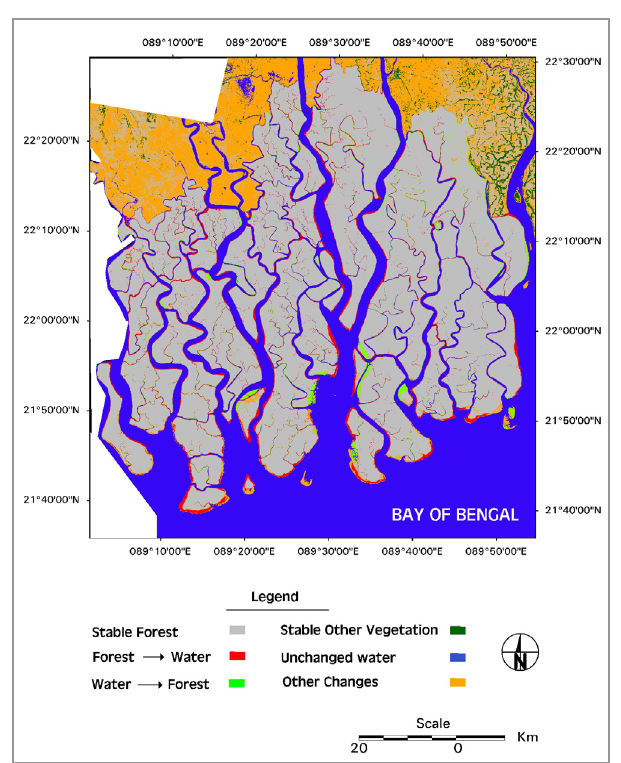
Figure 1. Shoreline changes in the Sundarbans mangrove forest (Bangladesh part,